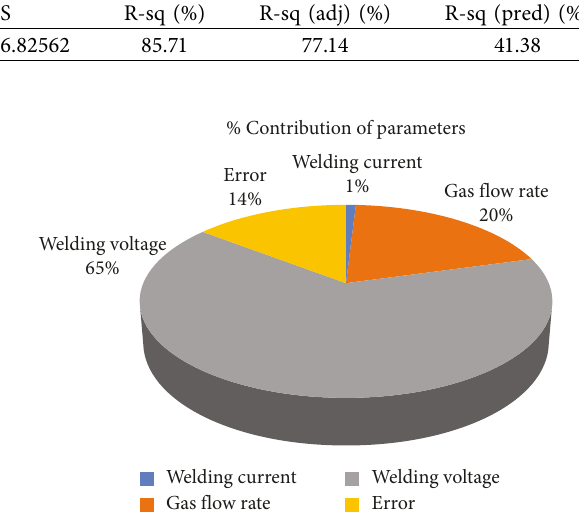
Table 7: Model summary for tensile strength.